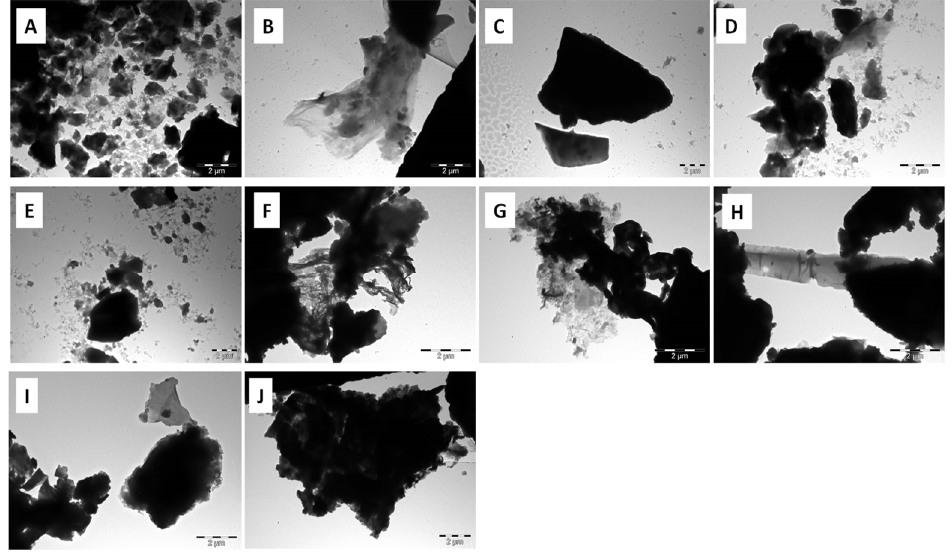
Figure 12. TEM images of coal ( A ), Coalgae ® 5% ( B ), Coalgae ® 10% ( C ), Coalgae ® 15% ( D ), and Coalgae ® 20% ( E ) and ash residues of coal ( F ), Coalgae ® 5% ( G ), Coalgae ® 10% ( H ), Coalgae ® 15% ( I ), and Coalgae ® 20% ( J ).